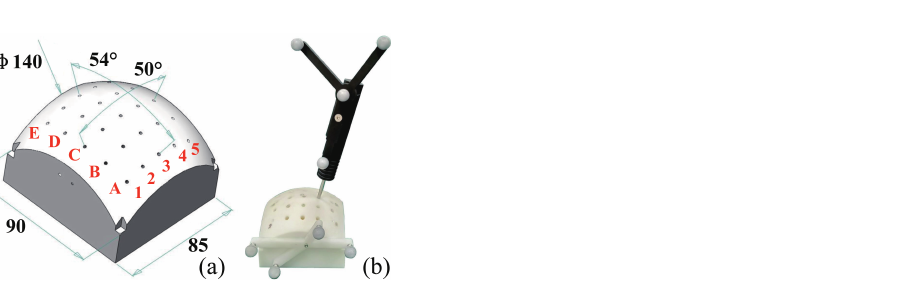
Figure 9. Plastic phantom for verifying hand-eye calibration. ( a ) geometric parameters; ( b ) using a tracked pointer to digitize actual drilling paths inside the phantom.